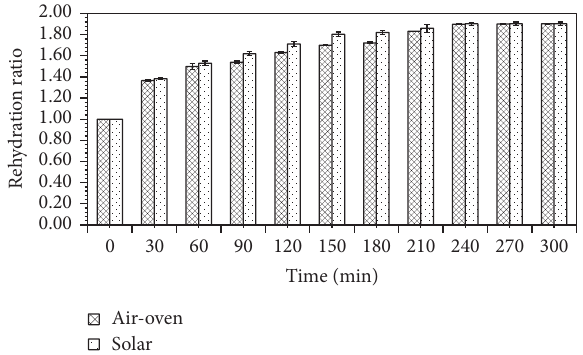
Figure 3: Rehydration characteristics of dried shrimp